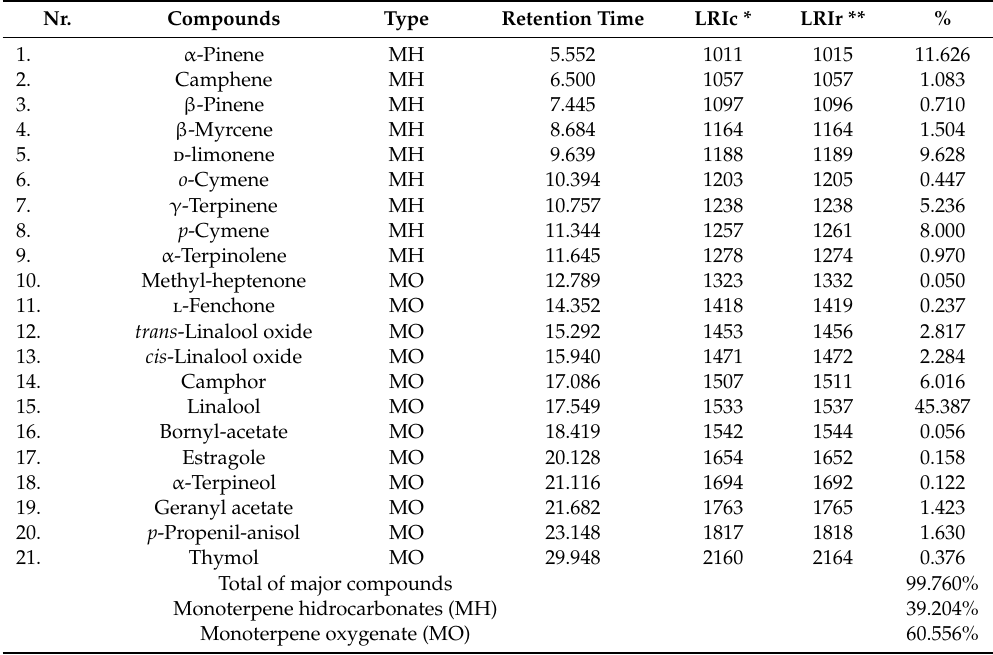
Table 1. The chemical composition of coriander essential oil (CEO) (% of